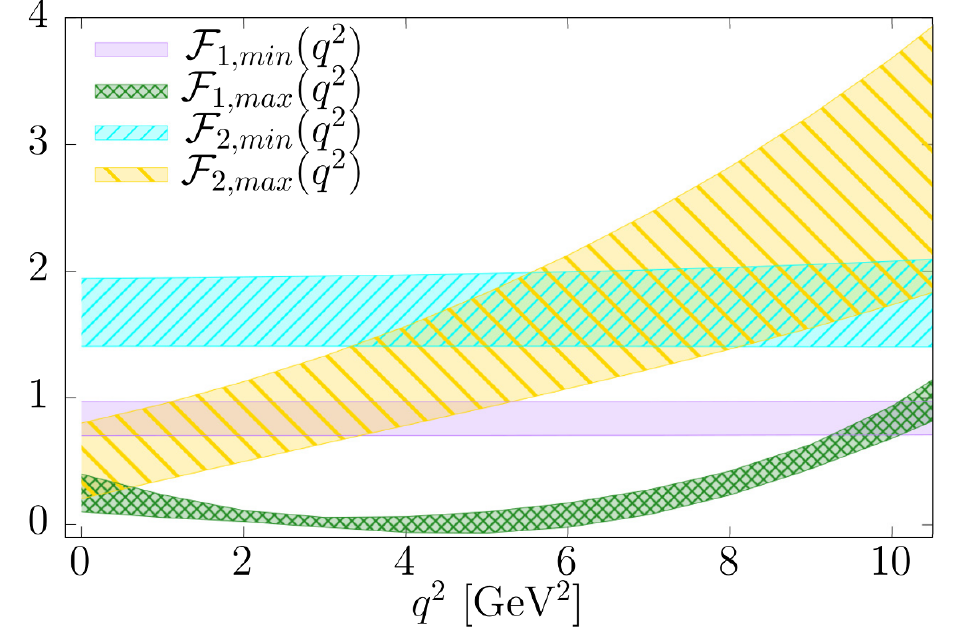
Figure 3 . Dimensionless form factors F 1 / [ 1 M 2 (1 − r 2 )] and F 2 that provide the maximum and 2 minimum R ( J/ψ ) values consistent with lattice and heavy-quark spin-symmetry constraints. The colored bands represent the 1 σ range due to the uncertainty associated with the HPQCD results, combined with an f lat =20% systematic